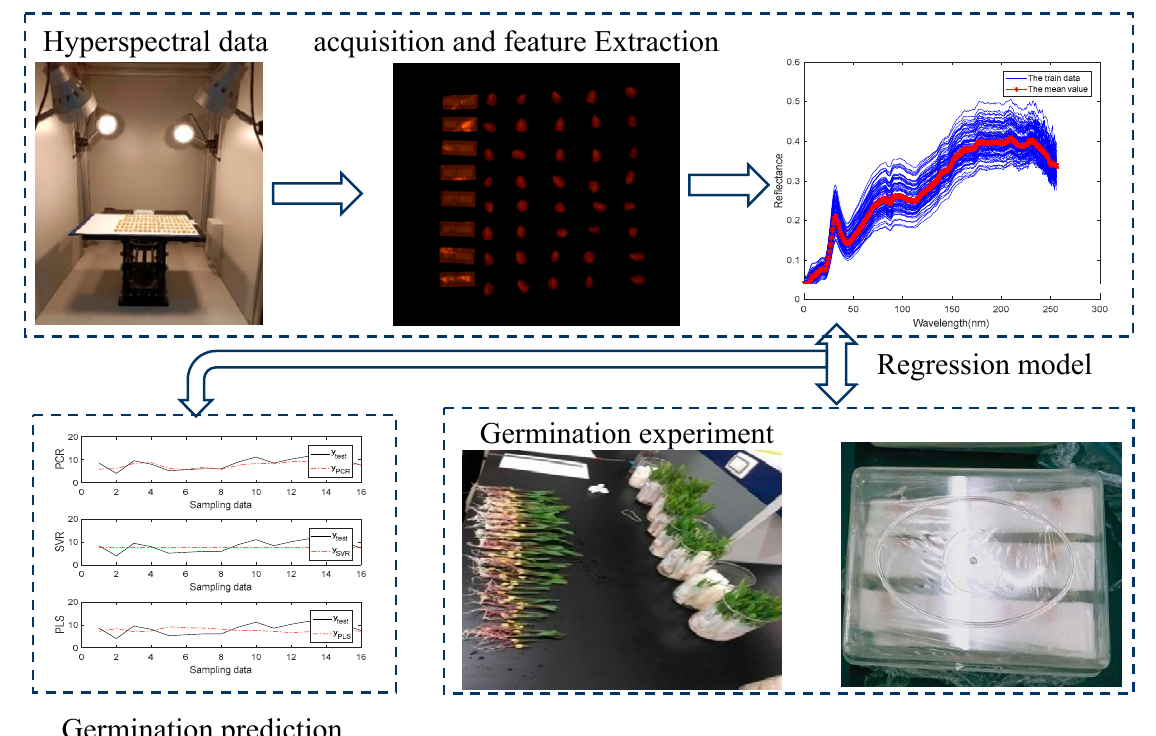
Figure 3. Process diagram of the maize seed germination prediction analysis.